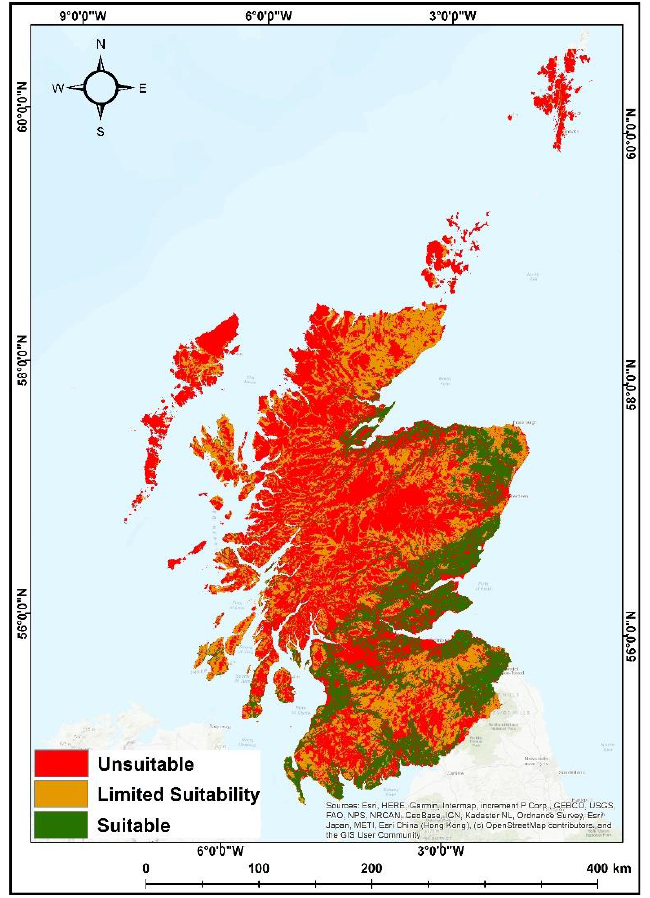
Figure 4. The suitability map of Sitka spruce based on biophysical